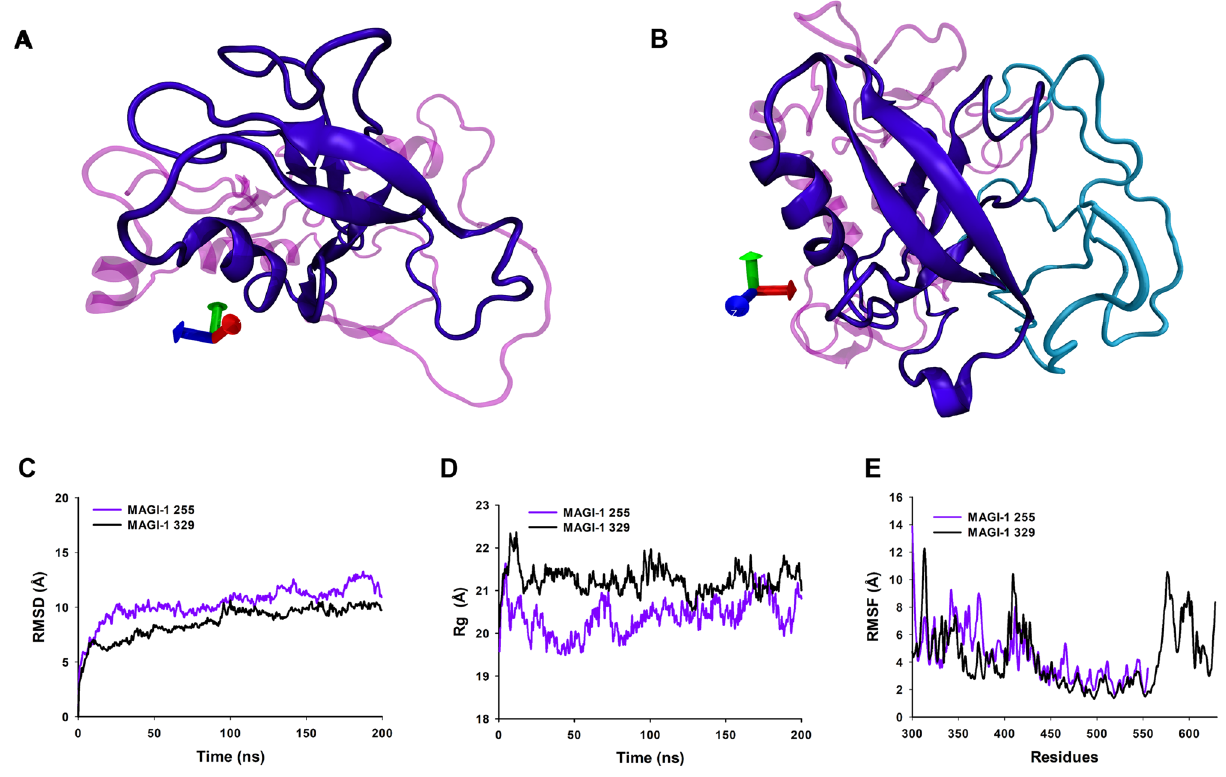
Figure 4. 3D structures of MAGI-1 255 and MAGI-1 329 and conformational stability during 200 ns MDs. ( A ) Visualization of MAGI-1 255. ( B ) Visualization of MAGI-1 329. The WW1 and the WW2 domains are shown in light pink, the PDZ1 domain is shown in violet, and a highly disordered region of 76 amino acids in cyan. ( C ) RMSD. ( D ) Radius of gyration. ( E )